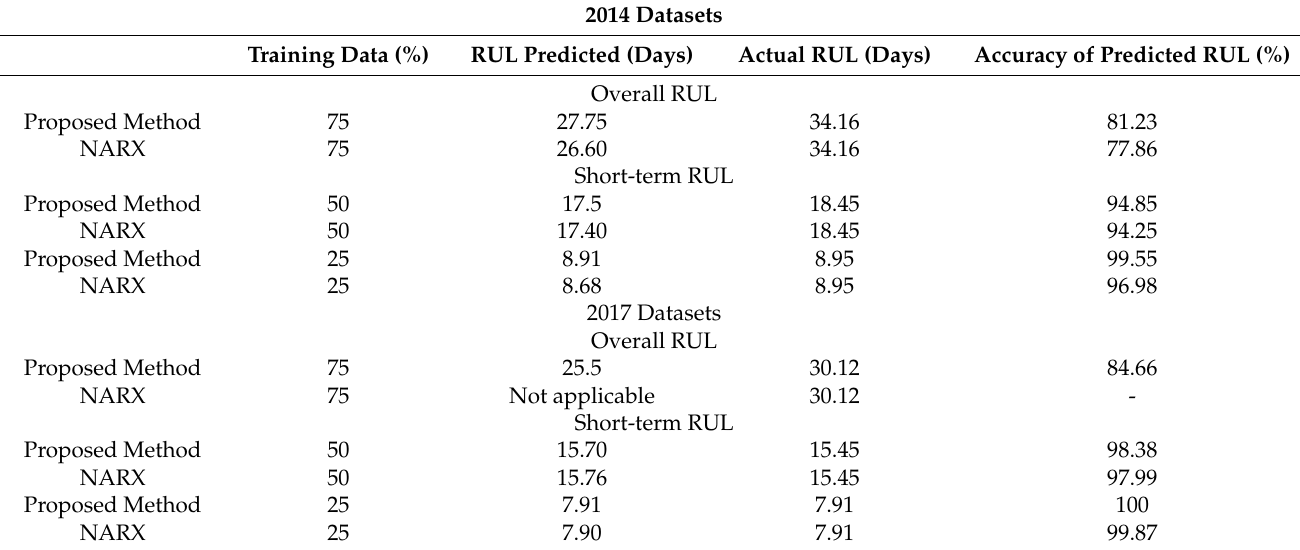
Table 2. The actual RULs, predicted RULs by the NARX and the developed model, and the accuracy of the obtained predicted RULs for slurry